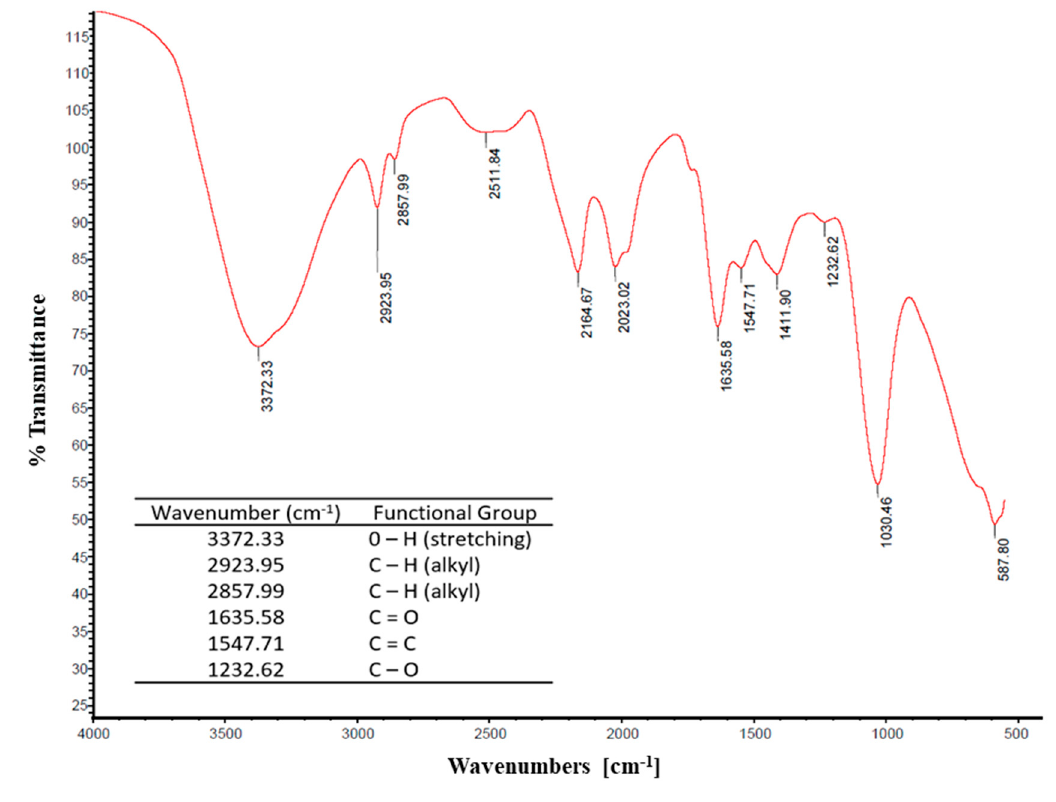
Figure 4. FT-IR spectrum analysis of biosurfactants Halomonas meridiana BK-AB4.